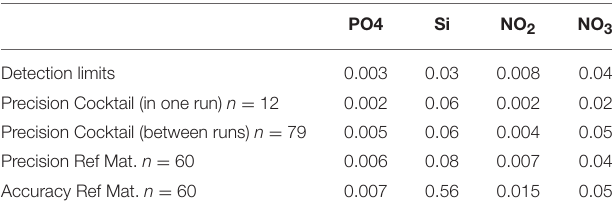
TABLE 1 | Detection limits, precision and accuracy in µ M of the nutrients.